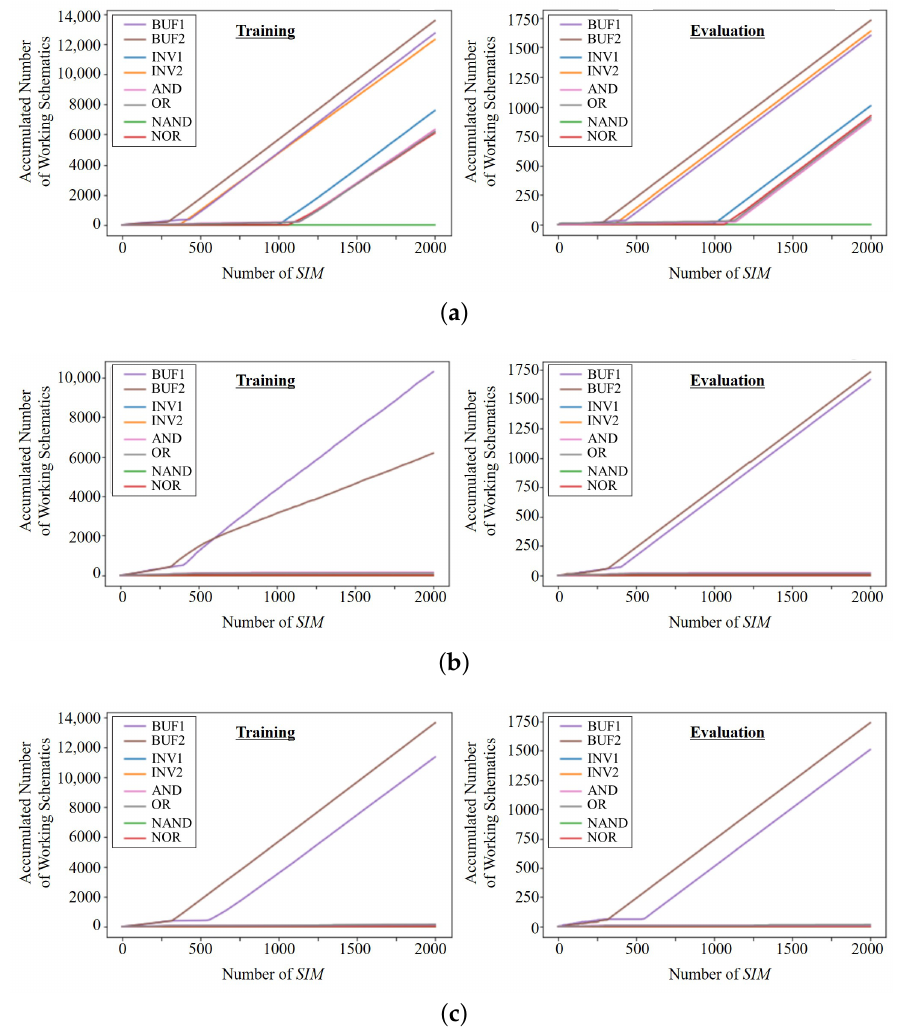
Figure 13. Plots of the number of extracted working schematics for target logic gates. ( a ) With a uniform P T and separate replay buffers ( b ) With an adaptive P T and one replay buffer. ( c ) With a uniform P T and one replay